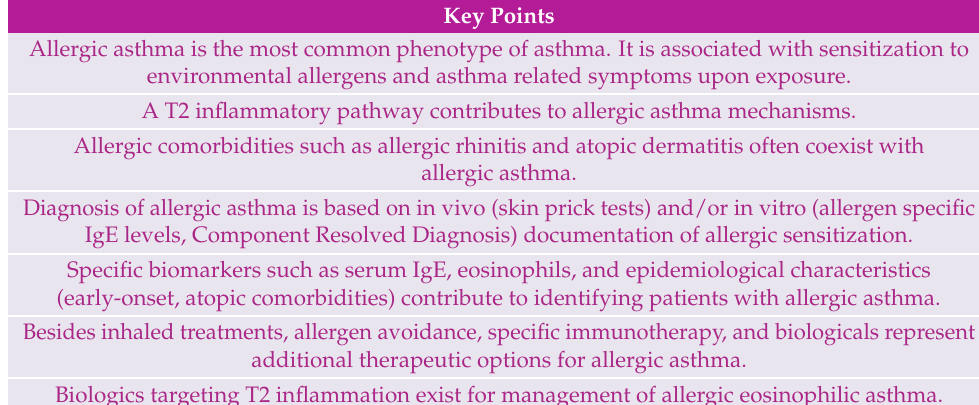
Table 1. Key points of allergic asthma in the era of personalized